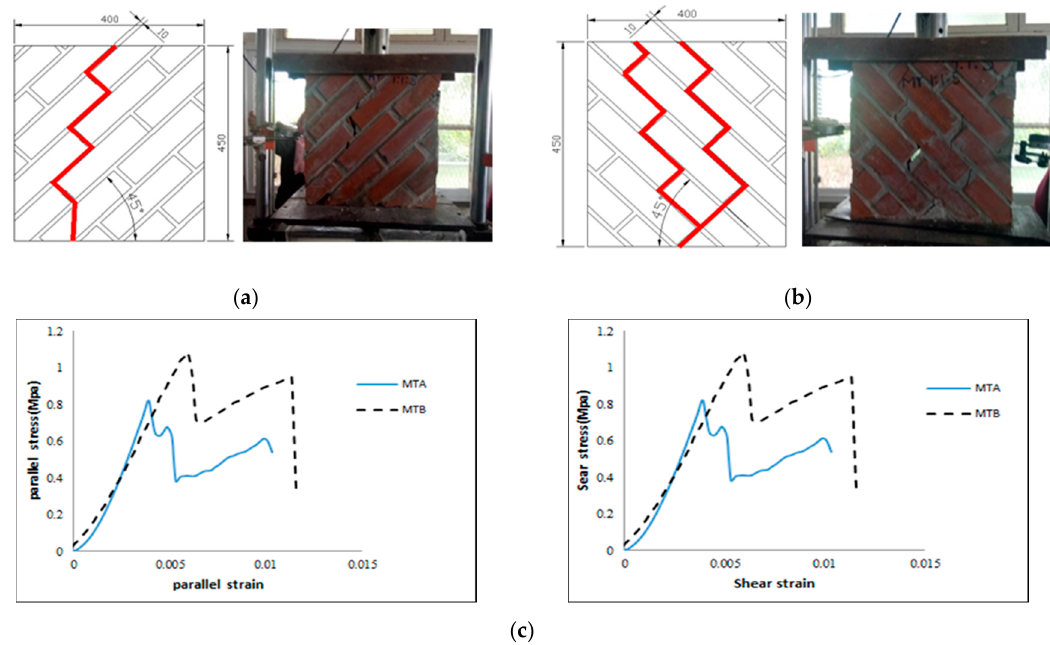
Figure 6. ( a ) Failure mode of unreinforced masonry walls 45° (MTA); ( b ) failure mode of unreinforced masonry walls 45° (MTB); ( c ) parallel and shear stress–strain relationships for masonry walls. Table 6. Comparison of uniaxial compressive stress of unreinforced and strengthened masonry panels. Bed Joint